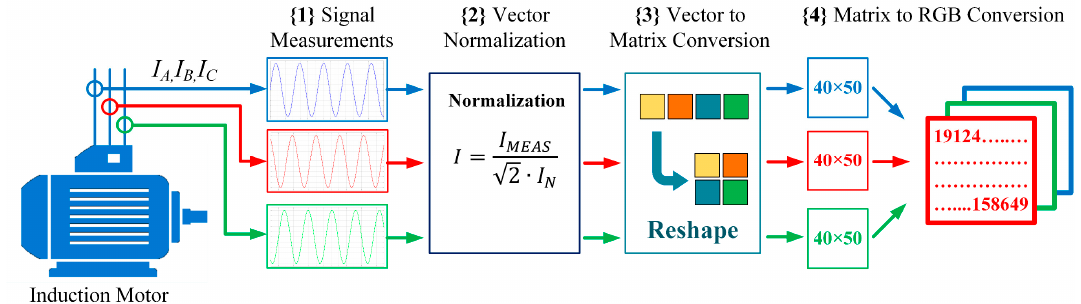
Figure 3. Elaboration of the input layer of the convolutional neural network (CNN) used for electrical fault detection of the induction motor—schematic diagram; I MEAS —measurement value of stator currents, I N —nominal value of stator currents.